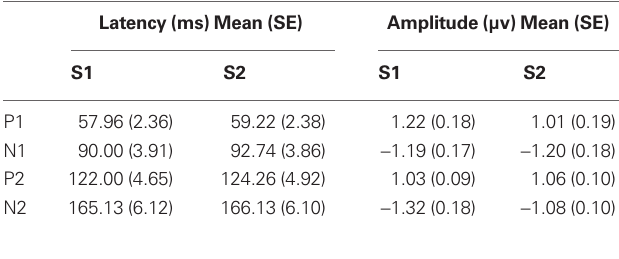
Table 1 | Mean values and standard errors (Se) for latency and amplitude of the S1 and S2 stimuli.